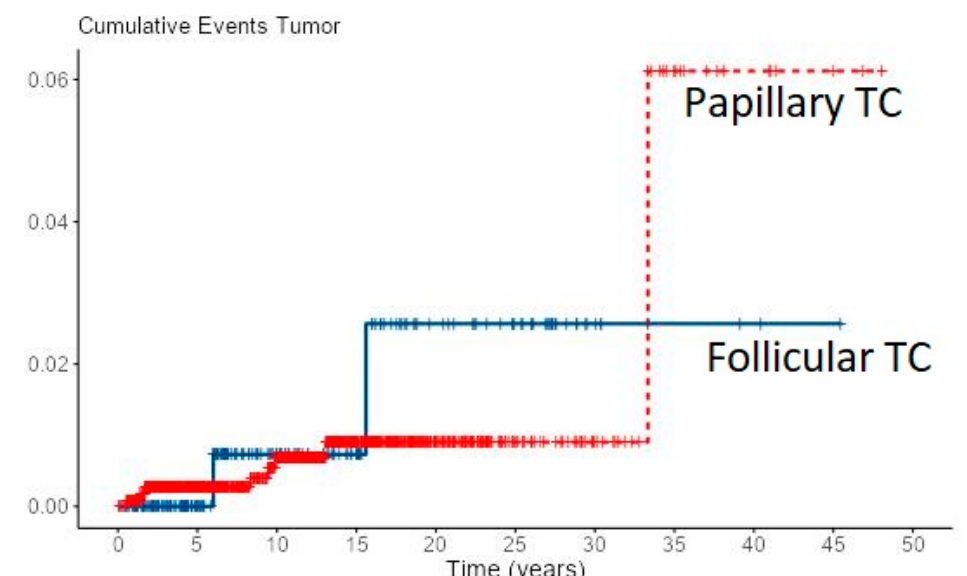
Figure 2. Cumulative events for new distant metastases of PTC and FTC.